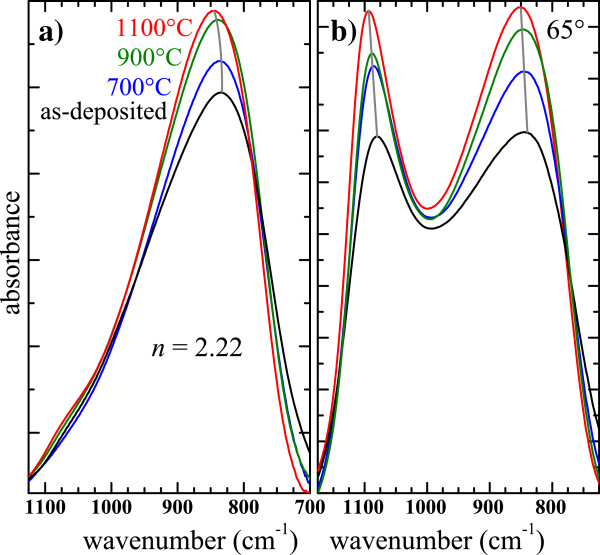
Effect of the annealing temperature on the FTIR spectra of SiNx. The FTIR spectra were recorded under normal incidence (a) and with an angle of 65° (b).